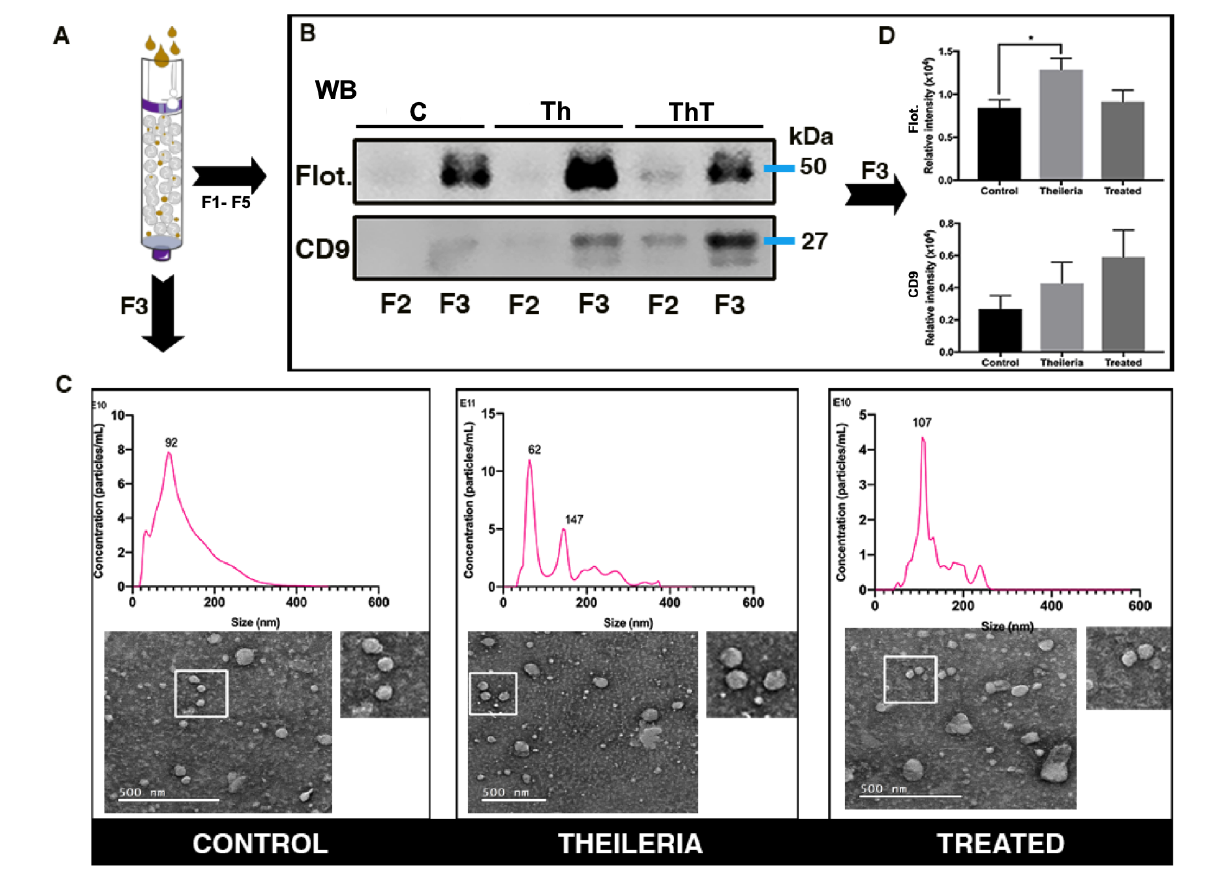
Figure 2. Isolation and characterization of EVs from buffalo serum. (A) Izon qEV size-exclusion chromatography columns. (B) Western blotting of Fractions 2 (F2) and 3 (F3) to the EV markers flotillin-1 and CD9 in control animals, Theileria spp. positive animals and treated animals. (C) Nanoparticle tracking analysis and transmission electron microscopy analysis in Fraction 3. (D) Densitometry of WB bands of Fraction